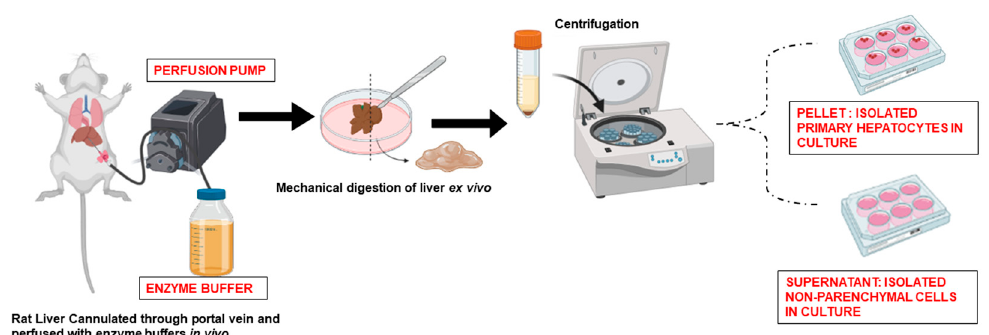
Figure 1. Schematic representation of the conventional method of isolation of primary hepatocytes and the non-parenchymal cell population of the liver through perfusion method. Original images by authors created with Biorender.com (accessed on 20 October